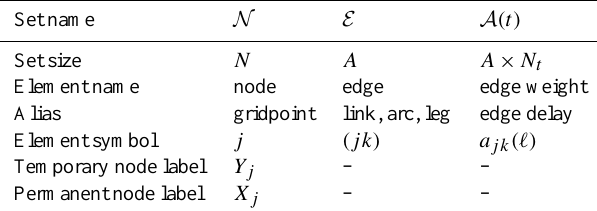
Table 1. Graph notation and relevant graph quantities used in this paper. N t is the number of time steps employed and is automatically adjusted by the model on the basis of the estimated voyage duration.